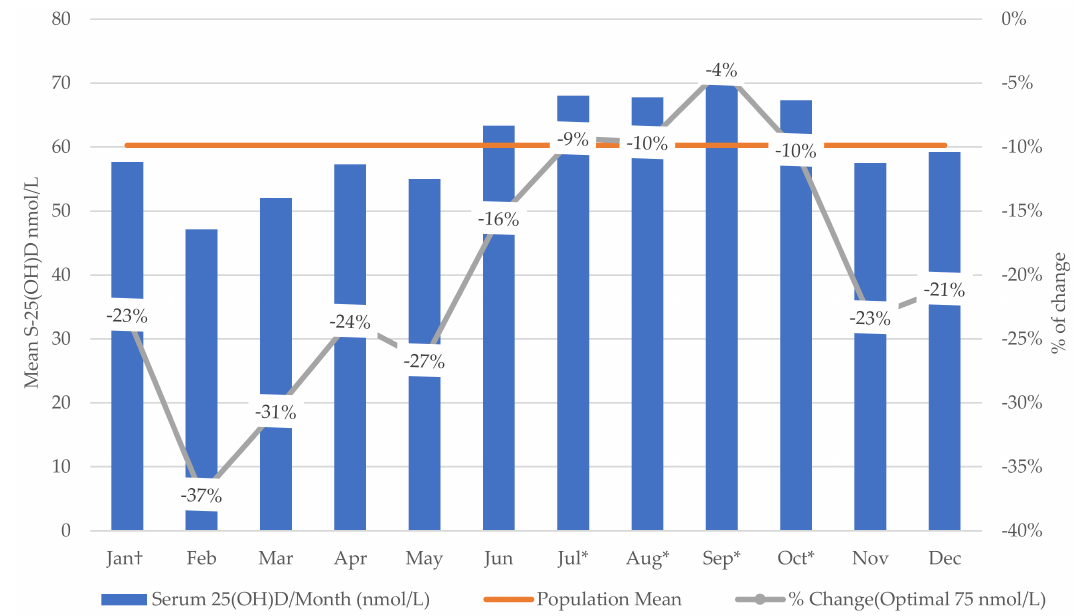
Figure 1. Weighted mean S-25(OH)D (nmol/L)/month of test and percentage of change from the optimal level (75 nmol/L) using Cycles 3 and 4 of Canadian Health Measures Survey data ( † reference value * significant at p ≤ 0.05).